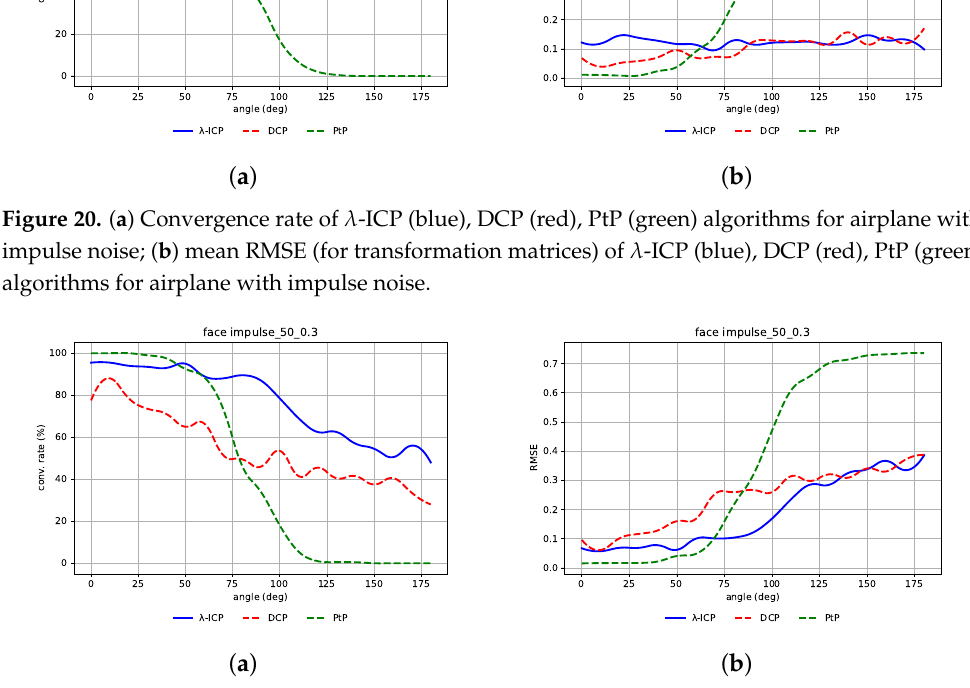
Figure 21. ( a ) Convergence rate of λ -ICP (blue), DCP (red), PtP (green) algorithms for human face with impulse noise; ( b ) mean RMSE (for transformation matrices) of λ -ICP (blue), DCP (red), PtP (green) algorithms for human face withi mpulse noise.